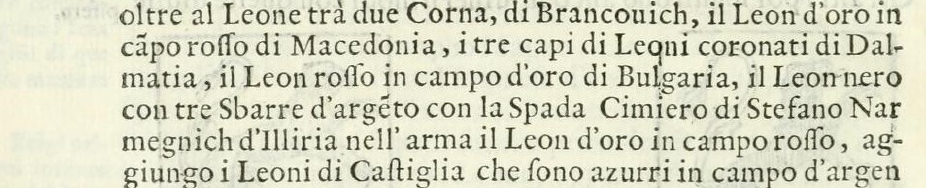
Figure 8. Passage from the Delle Imprese p.